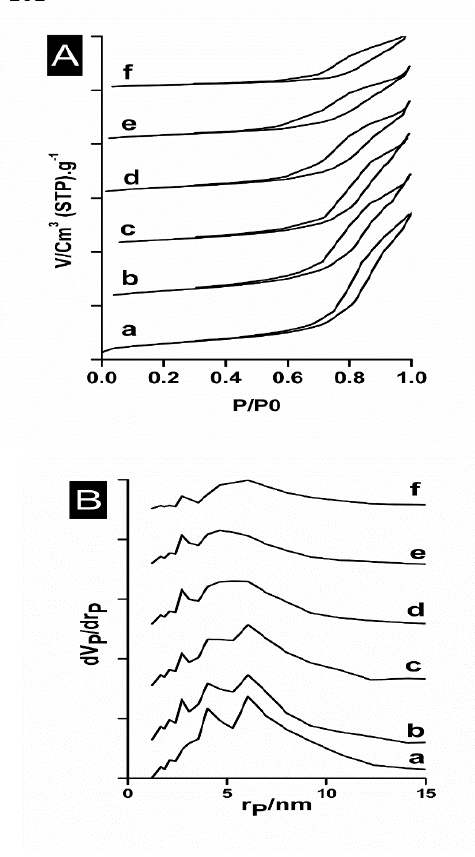
Fig. 1 . (A) N adsorption – desorption and (B) 2 BJH pore diameter distribution of (a) Alumina, (b) Zn Fe, (c) Zn Fe, (d) Zn 0.25 0.5 and (f) Zn Fe. 4